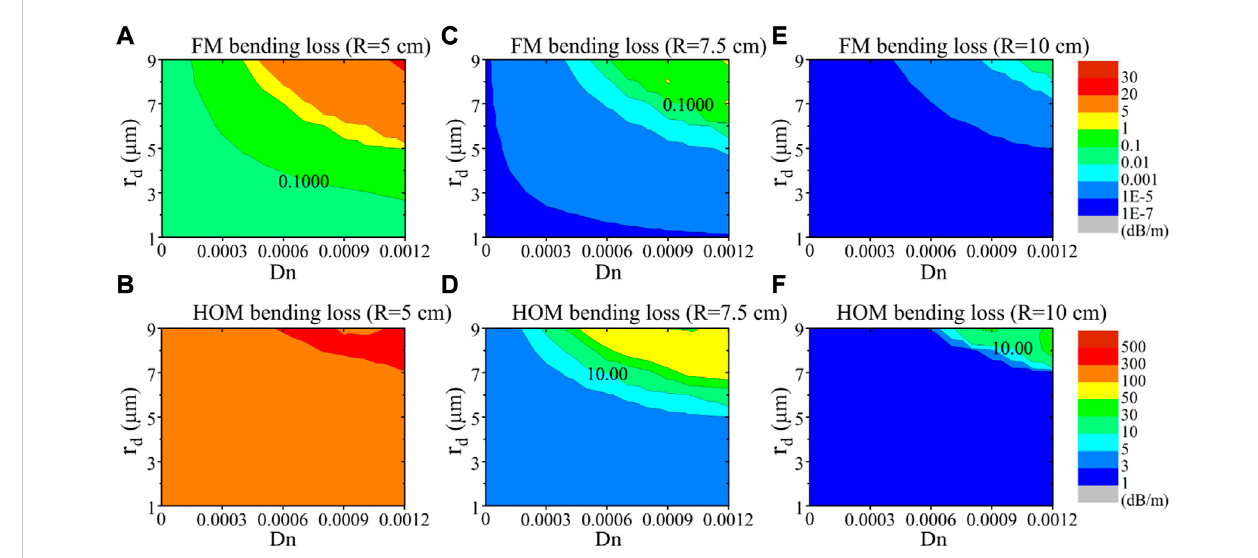
FIGURE 8 Bending loss under different bending radii. (A) FM loss and (B) HOM loss when R = 5 cm; (C) FM loss and (D) HOM loss when R = 7.5 cm; (E) FM loss and (F) HOM loss when R = 10 cm.